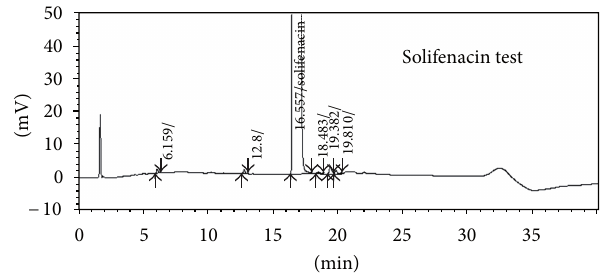
F 5: Typical HPLC chromatogram of solifenacin in assay